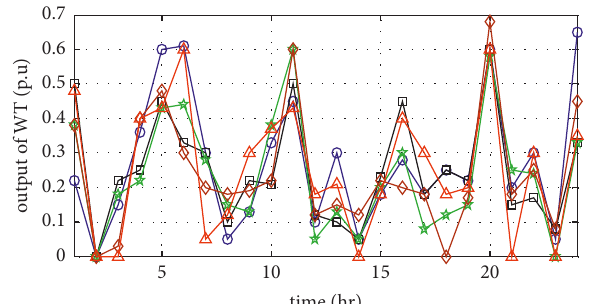
Figure 7: Wind power scenarios (p.u.).